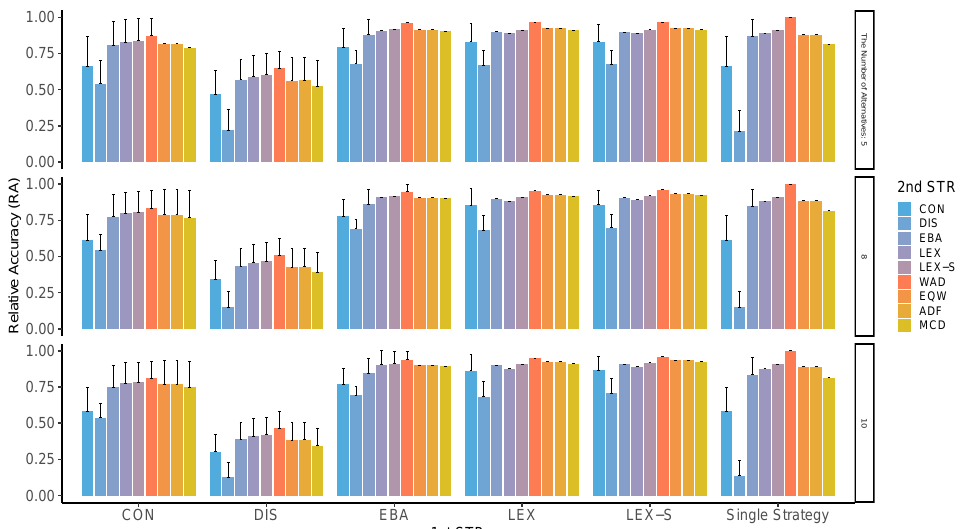
Figure A1. RA in two-stage decision-making when only two alternatives are left in the second stage. Note: ADF: additive difference; CON: conjunctive; DIS: disjunctive; EBA: elimination by aspects; EQW: equal-weighted strategy; LEX: lexicographic; LEX-S: lexicographic semi-order; MCD: majority of confirming dimensions; STR: strategy; WAD: weighted